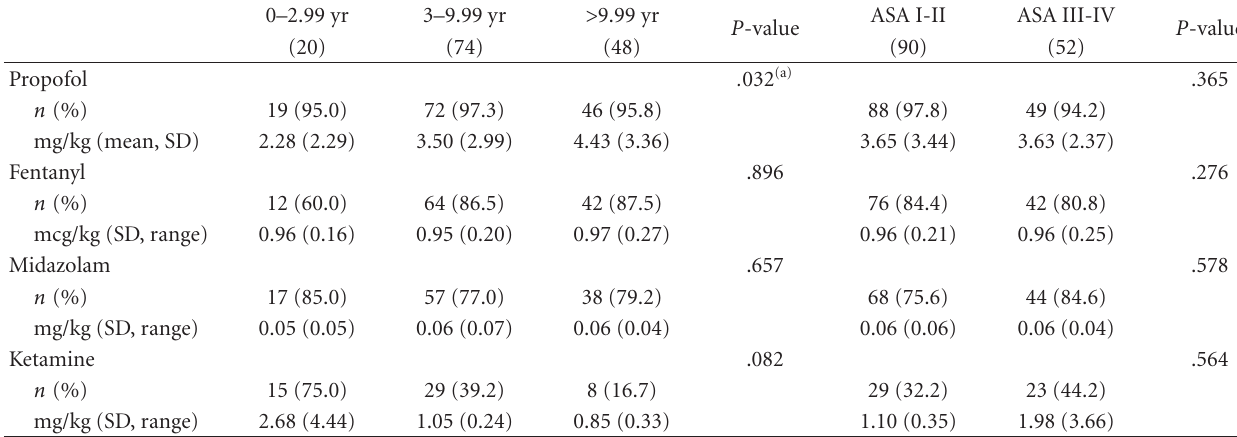
Table 2: Intravenous sedative agents used by age and ASA physical status.